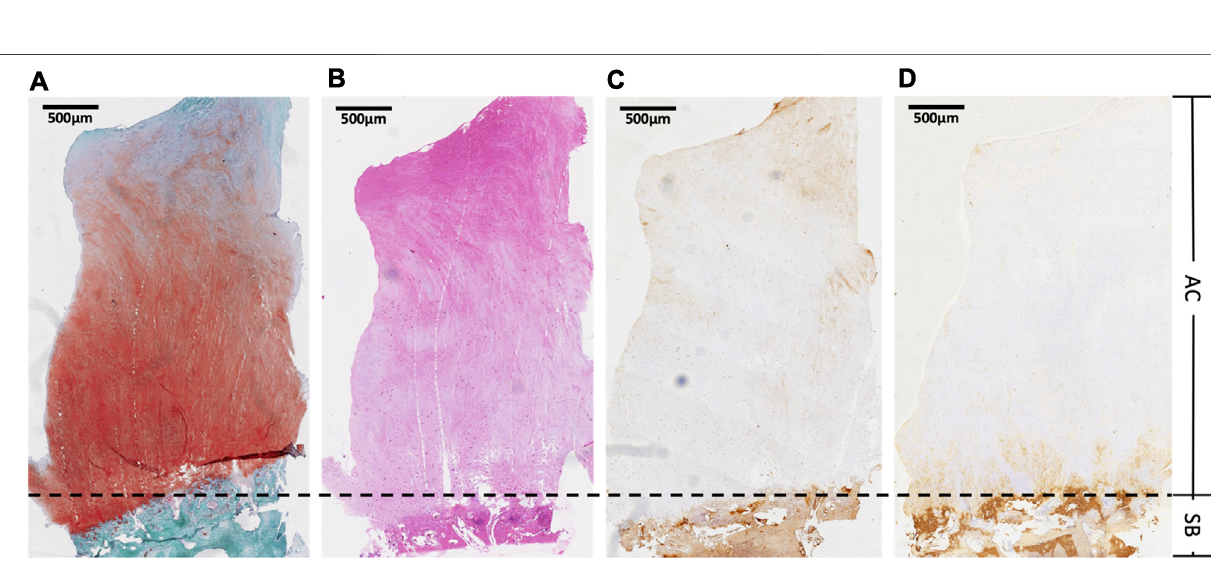
Frontiers in Bioengineering and Biotechnology |